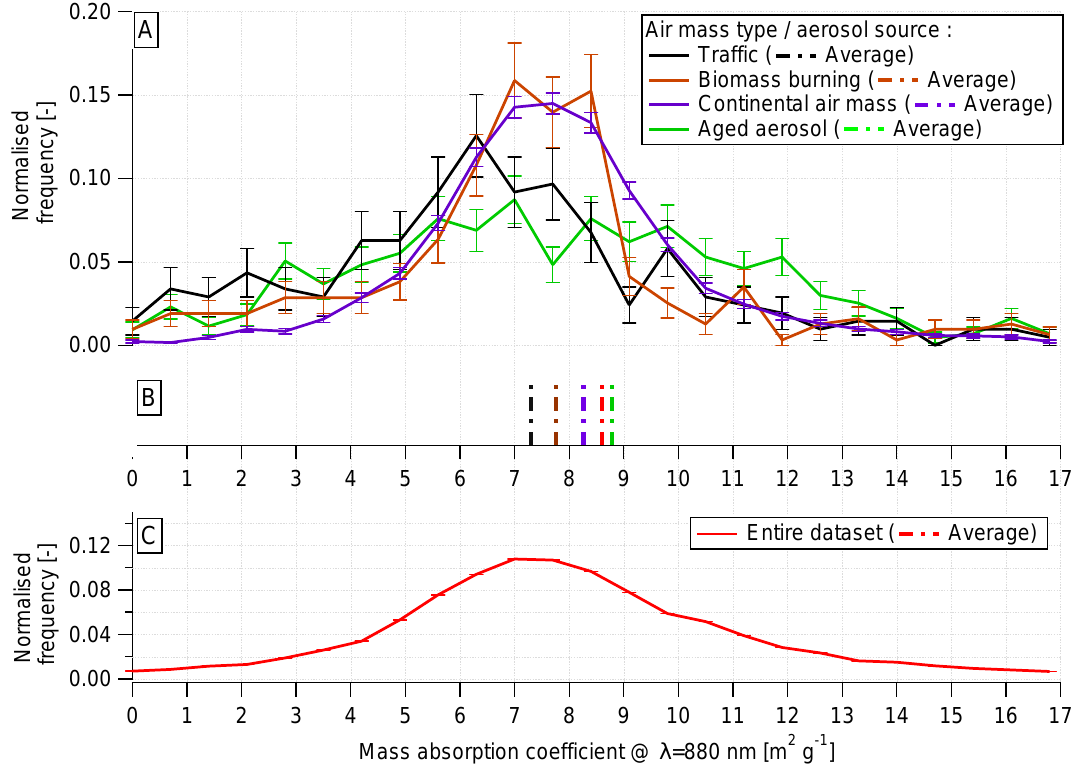
Fig. 12. Histogram (normalised to the area) of the mass absorption coefficients (MAC) for each air mass type/aerosol source (A) and calculated over the entire dataset (C) . Average MAC values corresponding to the histograms are shown in panel B. The MAC values were p obtained using Eq. (6). The error bars represent the statistical significance (1/ numberofpoints). Table 1. Averages of the coating thickness 1 coat of non-refractory matter on BC cores with a mass equivalent diameter of ∼ 200nm and ∼ 260nm, the mass absorption coefficient (MAC) and the toluene to benzene mixing ratios (T/B) for each air mass type or aerosol source investigated and for the entire measurement